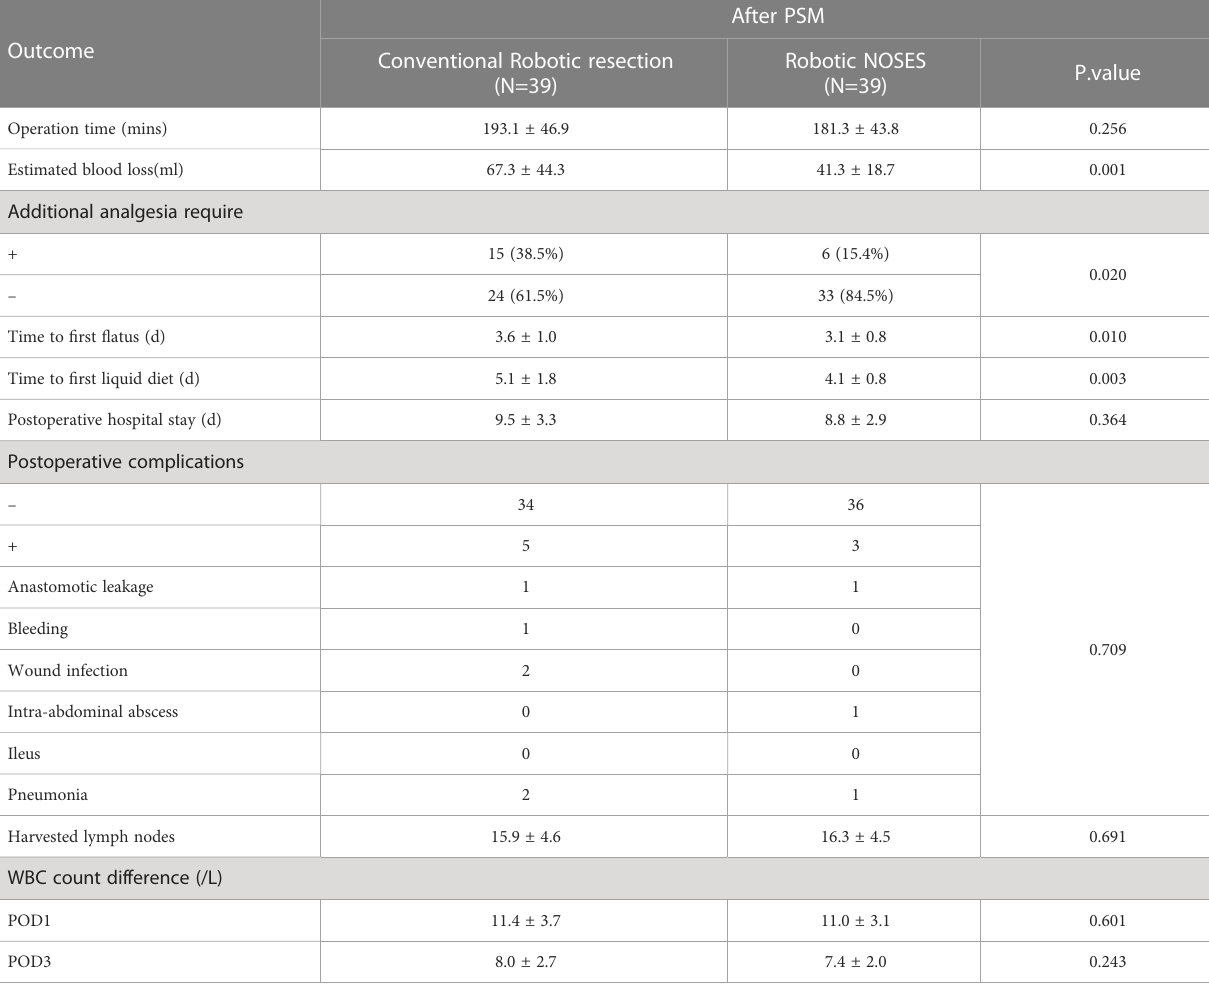
TABLE 2 Short-term clinical outcomes. p<0.05 are indicated in